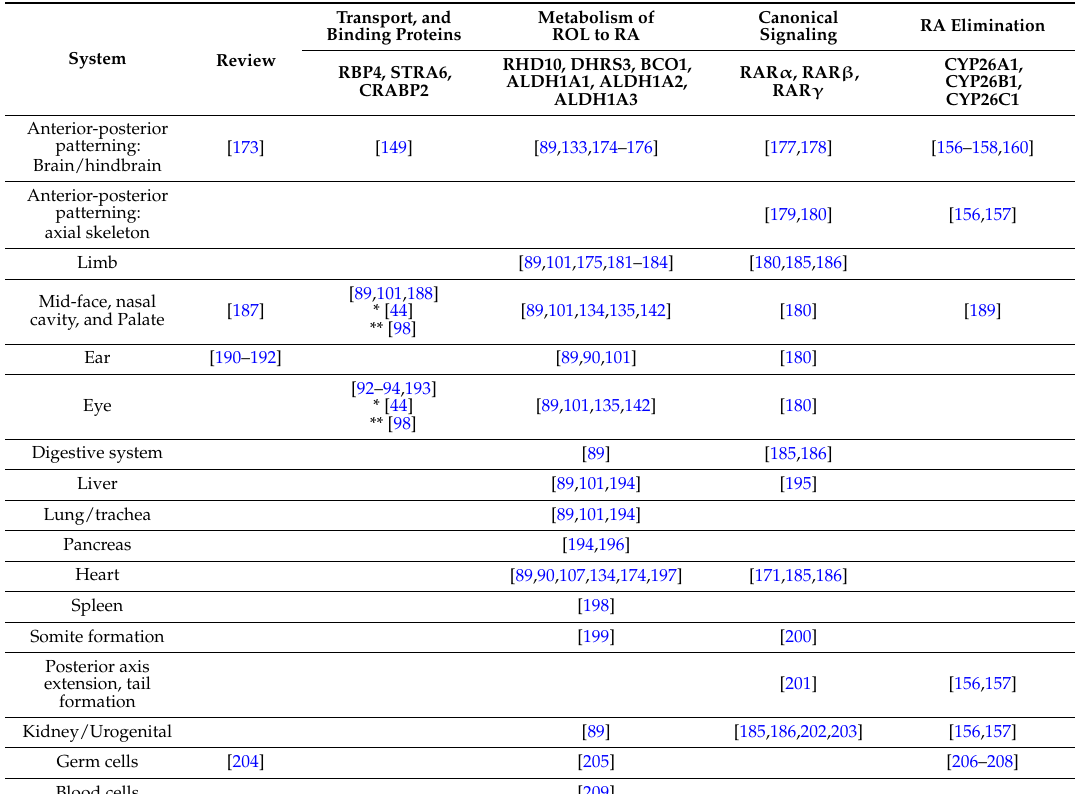
Table 2. Mutations or morpholino knock-down of genes involved in vitamin A metabolism and RA signaling impact development of many embryonic